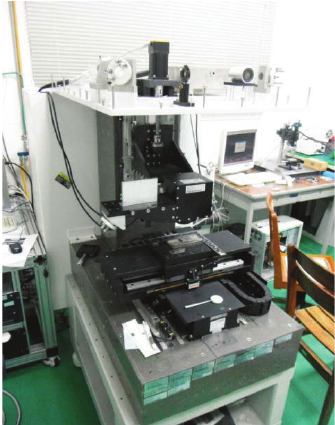
Figure 2: UV laser processing machine of the study laboratory